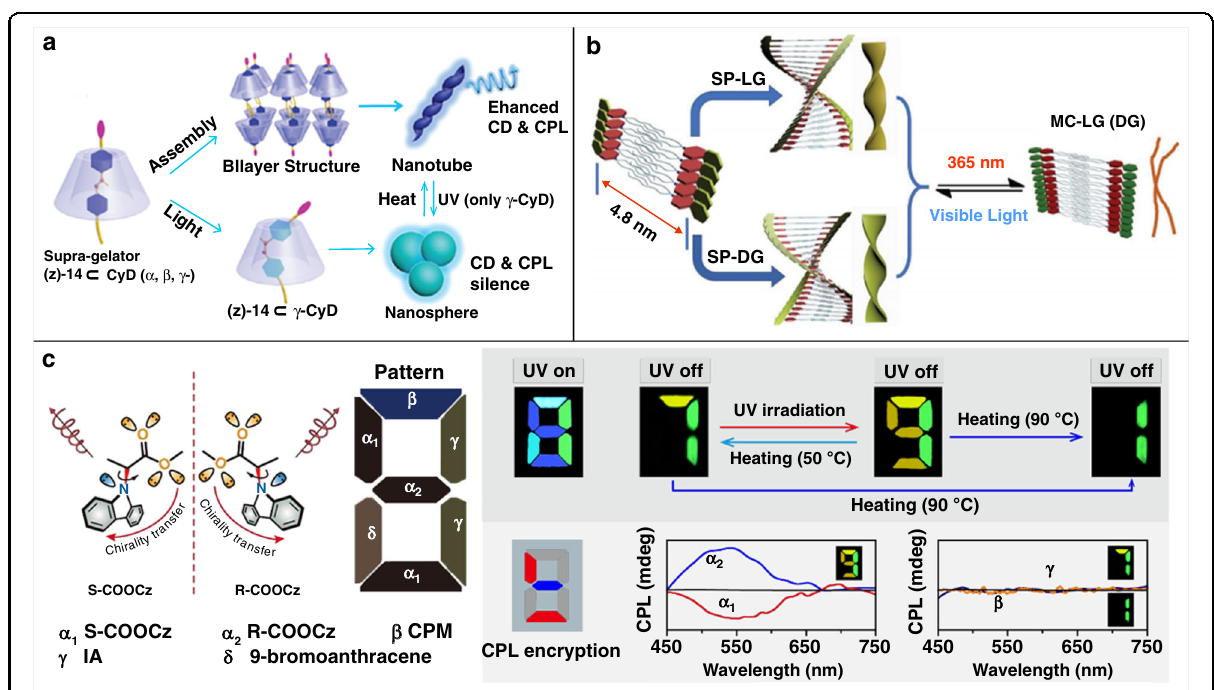
Fig. 9 Applications in optical information processing. a Schematic illustration of photo-responsive CPL-active supramolecular assembly based on Z – E isomerization of cyanostilbene. b Schematic illustration of the reversible chiroptical switching of self-assembled spiropyran gels. c Illustration of CPL-featured lifetime-encrypted integrated logic device. Images reprinted with permission from: a ref. 120 from RSC; b ref. 121 ; c ref. 125 from